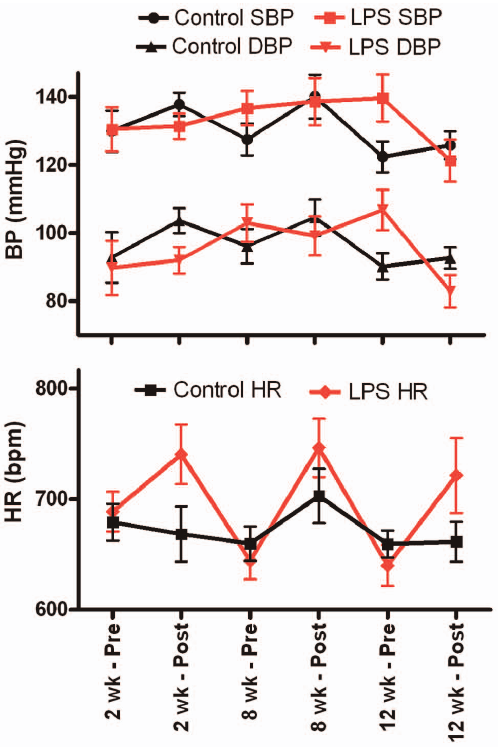
Figure 3. Hemodynamics with weekly injections of LPS for 12 weeks. Tail cuff systolic and diastolic blood pressure (SBP, DBP) and heart rate (HR, beats per minute, bpm) measured in conscious mice before (Pre) and 24 hours after (Post) weekly i.p. injections of saline (n=7) or LPS (20 mg/kg, n=6). Data (mean 6 SEM) averaged over three weeks at 2 wk (1–3 weeks), 8 wk (7–9 weeks) and 12 wk (weeks 11–13). Hemodynamics were stable with no significant trends from 2 to 12 weeks. There was an interaction between LPS and the Pre-Post injection for SBP (P=0.044), DBP (P=0.015) and HR (P=0.011) (mixed model analysis) reflecting small but consistent differences in HR and BP responses 24 hours after LPS compared with saline.